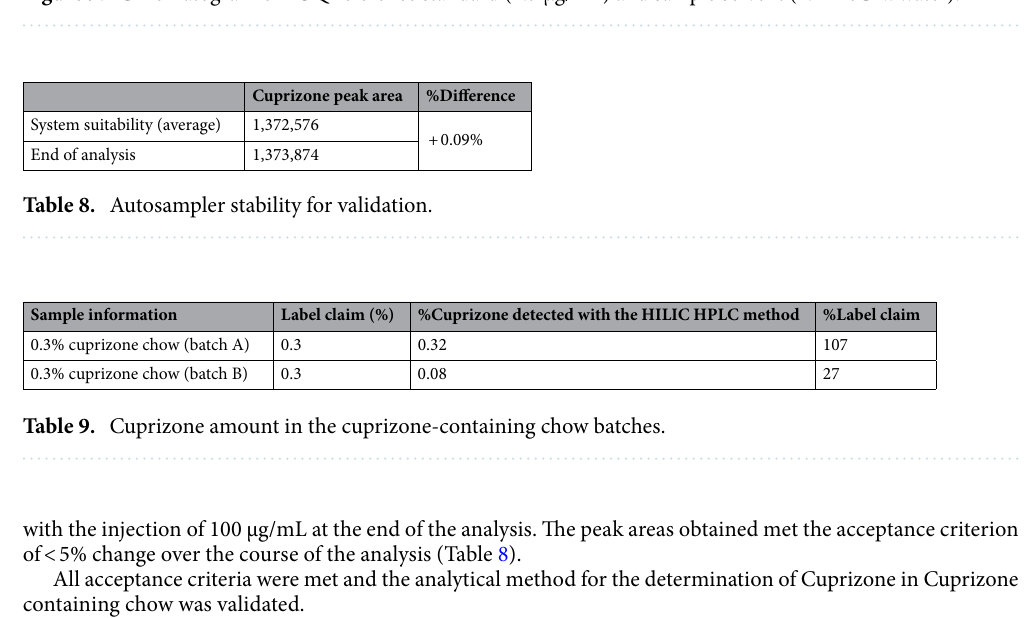
Figure 9. Chromatogram of LOQ reference standard (2.5 μg/mL) and sample solvent (1:1 MeCN: water).